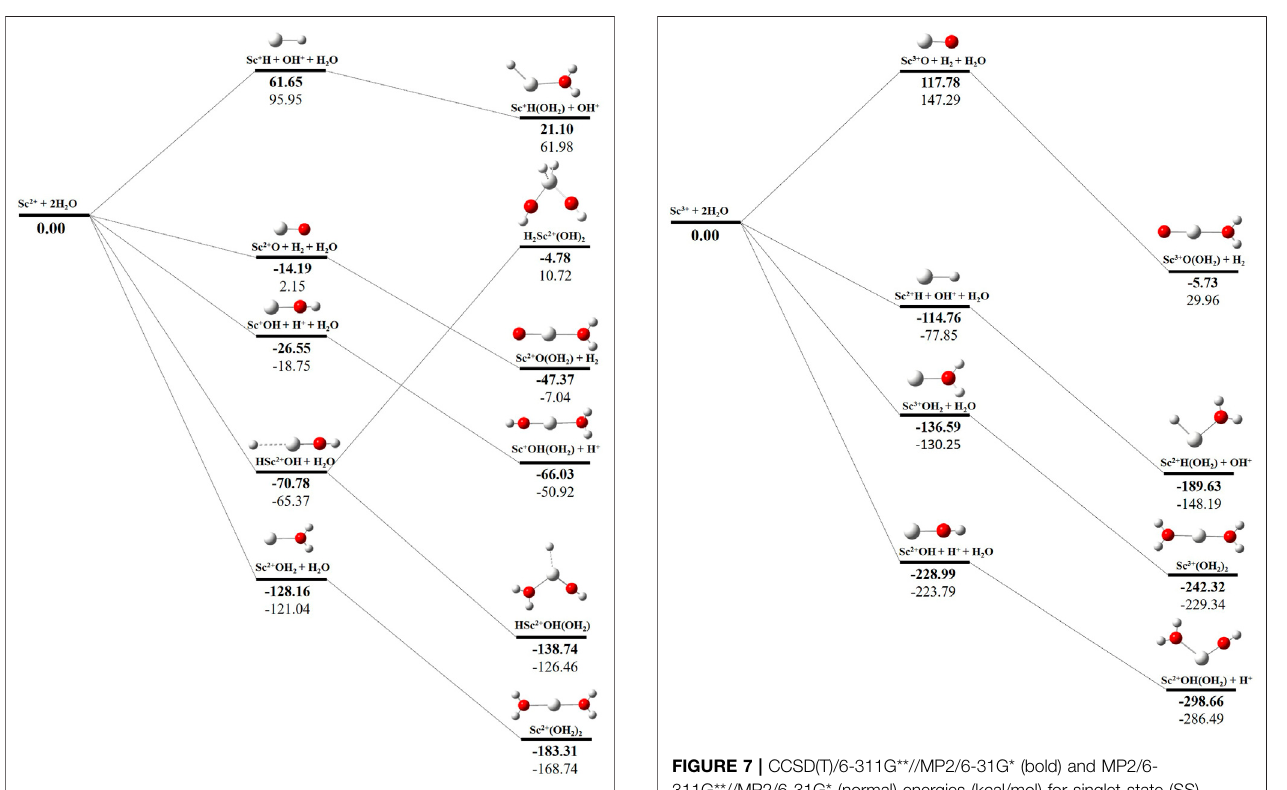
FIGURE 6 | CCSD(T)/6-311G**//MP2/6-31G* (bold) and MP2/6- 311G**//MP2/6-31G* (normal) energies (kcal/mol) for doublet-state (DS) potentialenergysurfacesfollowingSc 2+ +2H 2 Oreaction.Thesumofreactant pair energy (Sc 2+ + 2H 2 O) is considered as a standard (energy zero) to calculate the relative energy.